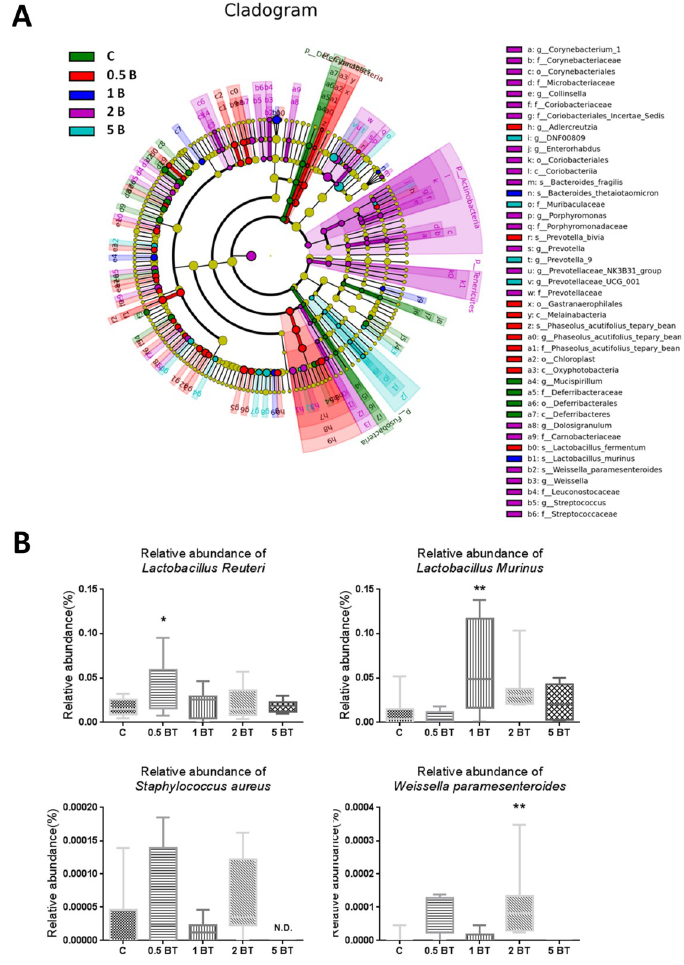
Fig 7. Variations of gut microbiota after BT treatment at species level. (A) LEfSe taxonomic cladogram derived from 16S sequences of gut microbiota among groups. Different colors represented significantly different taxa among groups. (B) The effects of drinking BT on the relative abundance of gut microbiota in species level. Drinking BT increased the relative abundance of Weissella paramesenteroides , Lactobacillus reuteri , and Lactobacillus murinus , whereas decreased the relative abundance of Staphylococcus aureus (n = 8). C, control; 0.5B, 0.5BT; 1B, 1BT; 2B, 2BT; 5B, 5BT; N.D., not detected. Data of relative abundance are depicted in box and whisker plots and are analyzed by one- way ANOVA. � P < 0.05; �� P <